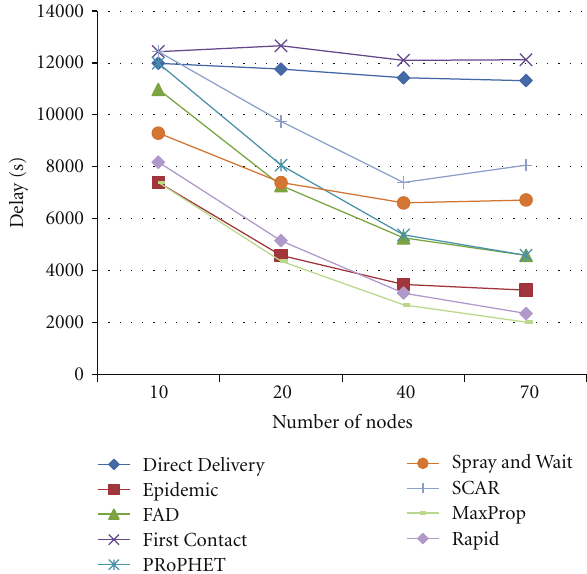
Figure 4: Latency result